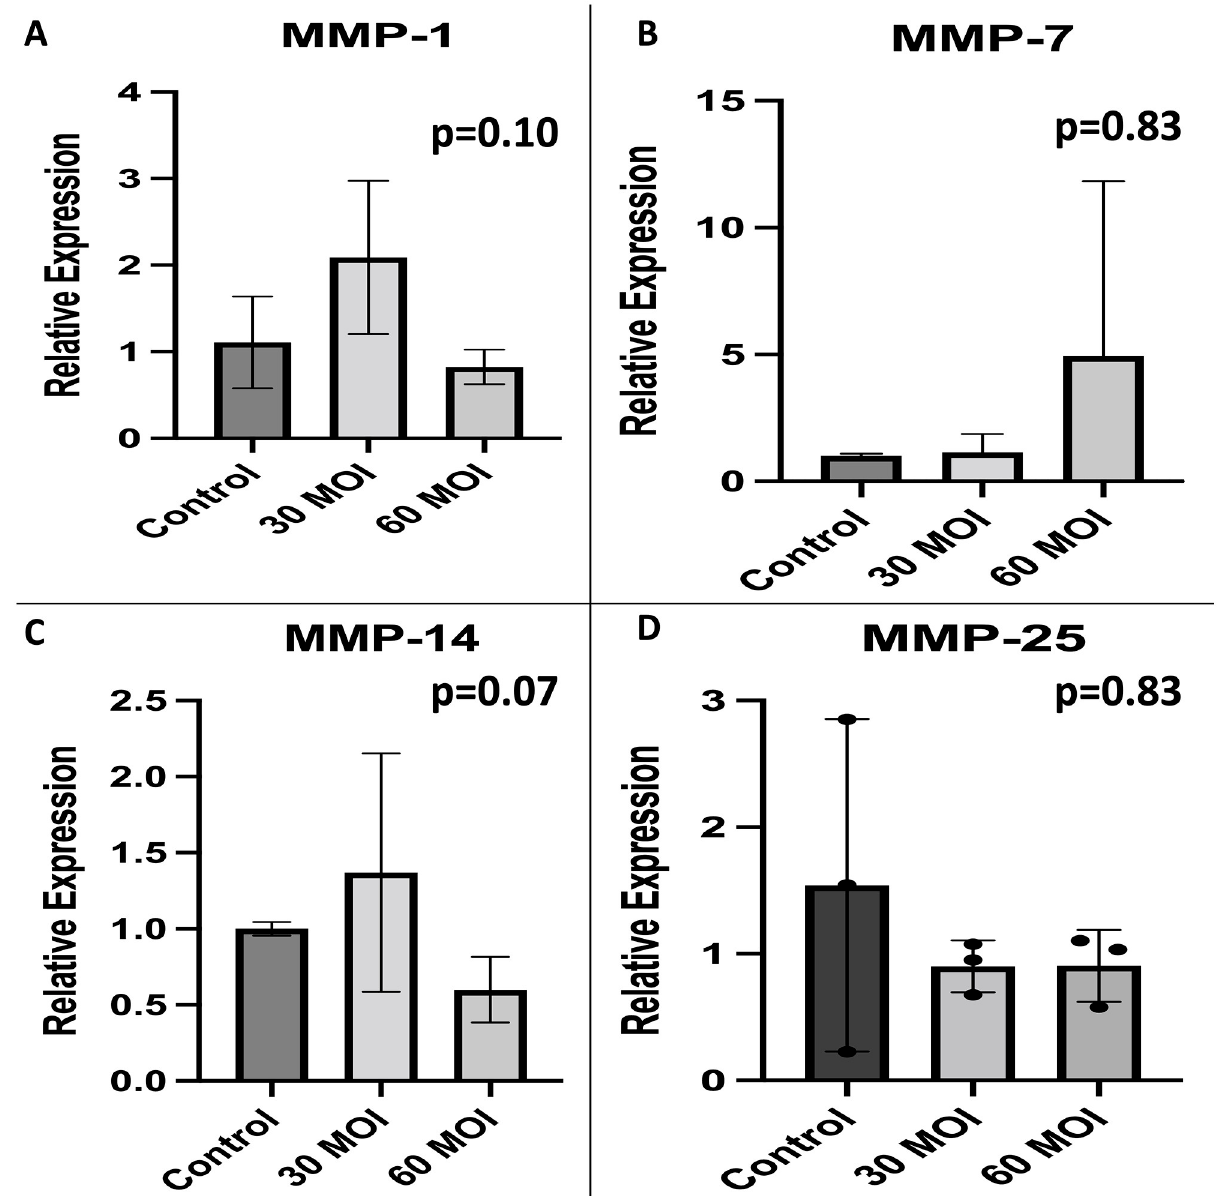
Fig 5. Comparison of metalloproteinase levels. A comparison of metalloproteinase expression as measured by real-time PCR demonstrating that there is no difference in A) MMP-1, B) MMP-7, C) MMP-14, and 4) MMP-25 expression when H1N1 infected human umbilical vein endothelial cells are compared to